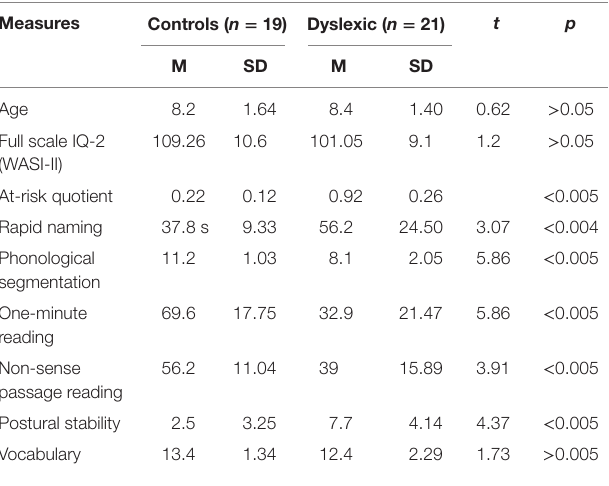
TaBle 1 | linguistic and cognitive measures.